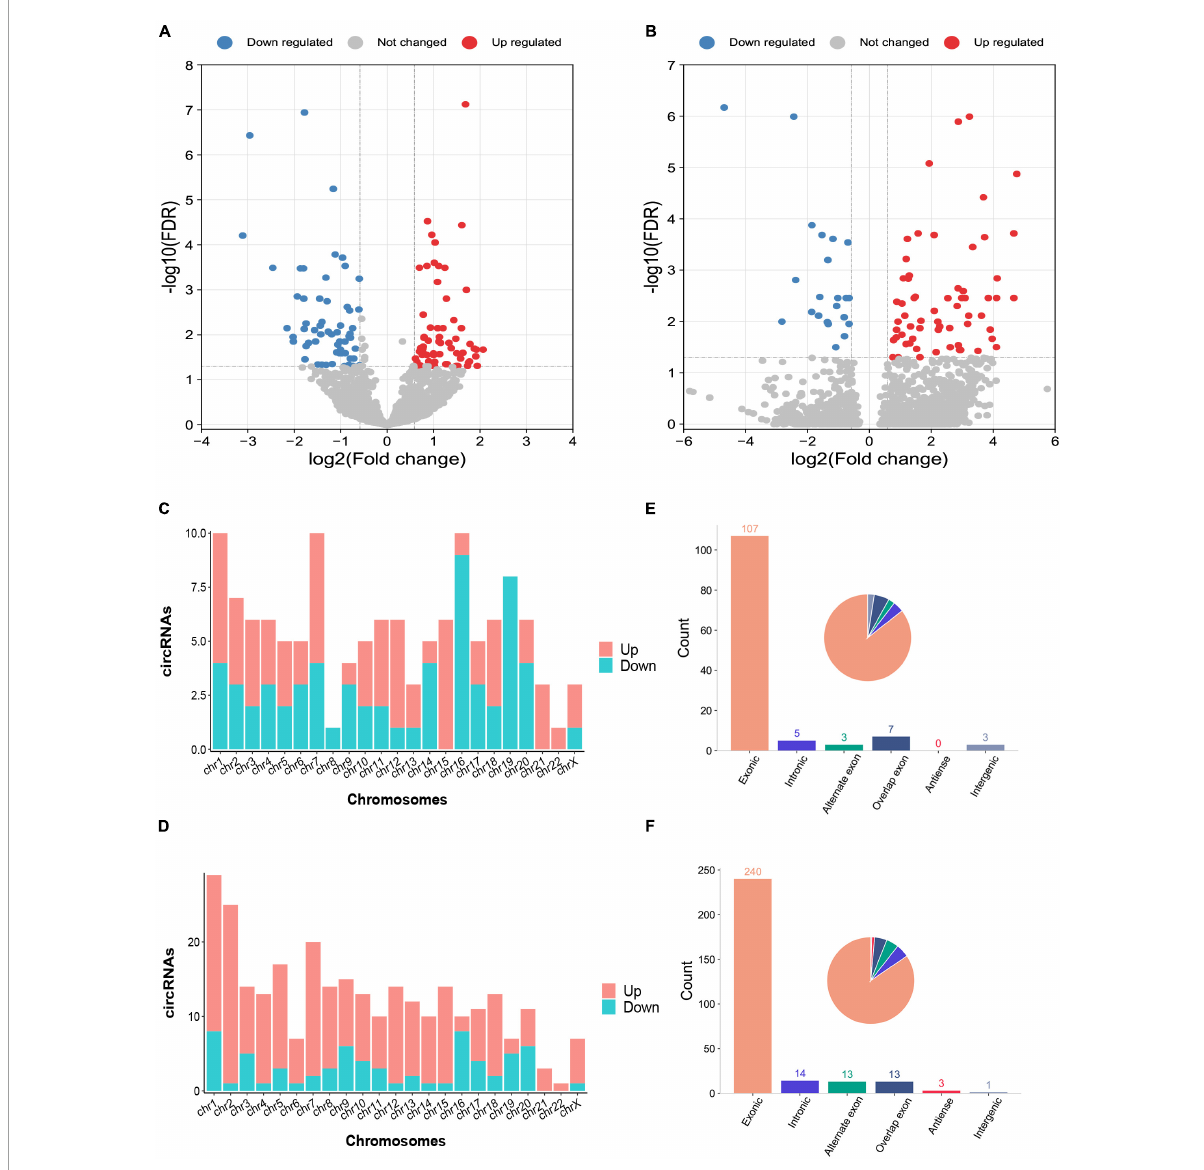
FIGURE1 Differentially expressed circRNAs between intracerebral hemorrhage (ICH) patients and healthy controls in the discovery and validation cohorts. (A,B) The volcano plot of circRNA expression profiles in ICH patients and controls (fold change ≥ 1.5 and FDR < 0.05) in the discovery ( n = 44 vs. 31) (A) and validation ( n = 20 vs. 19) (B) cohorts. Red dots represent upregulated genes, and blue dots represent downregulated genes. (C) The bar diagram shows the circRNA distribution in the chromosomes between 44 ICH patients and 31 healthy controls in the discovery cohort. The red columns represent upregulated circRNAs, while blue columns represent downregulated circRNAs. (D) The bar diagram shows the circRNA distribution in the chromosomes between 20 ICH patients and 19 healthy controls in the validation cohort. The red columns represent upregulated circRNAs, while blue columns represent downregulated circRNAs. (E) The bar diagram and pie chart show the differentially expressed circRNA distribution in the chromosome region (exonic, intronic, intergenic, alternate exon, overlapping exon and antisense) in 44 ICH patients compared with 31 healthy controls in the discovery cohort. (F) The bar diagram and pie chart show the differentially expressed circRNA distribution in the chromosome region (exonic, intronic, intergenic, alternate exon, overlapping exon and antisense) in 20 ICH patients compared with 19 healthy controls in the validation